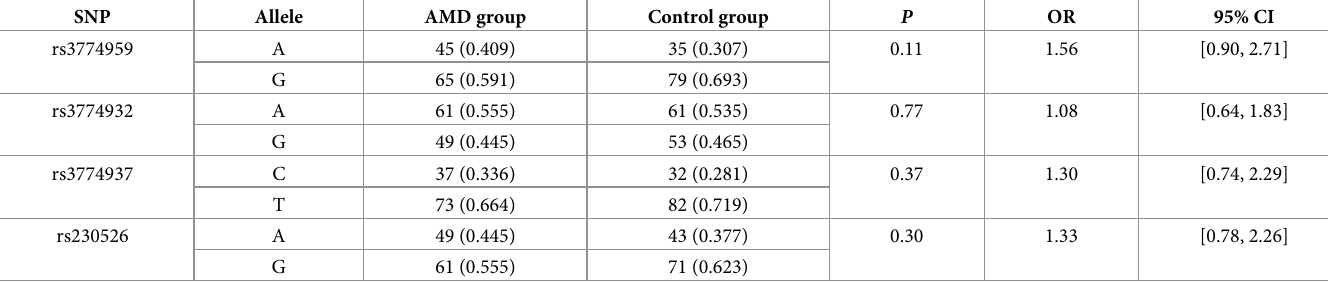
Table 4. Genotype distributions of NF-kB gene polymorphisms in patients with AMD and